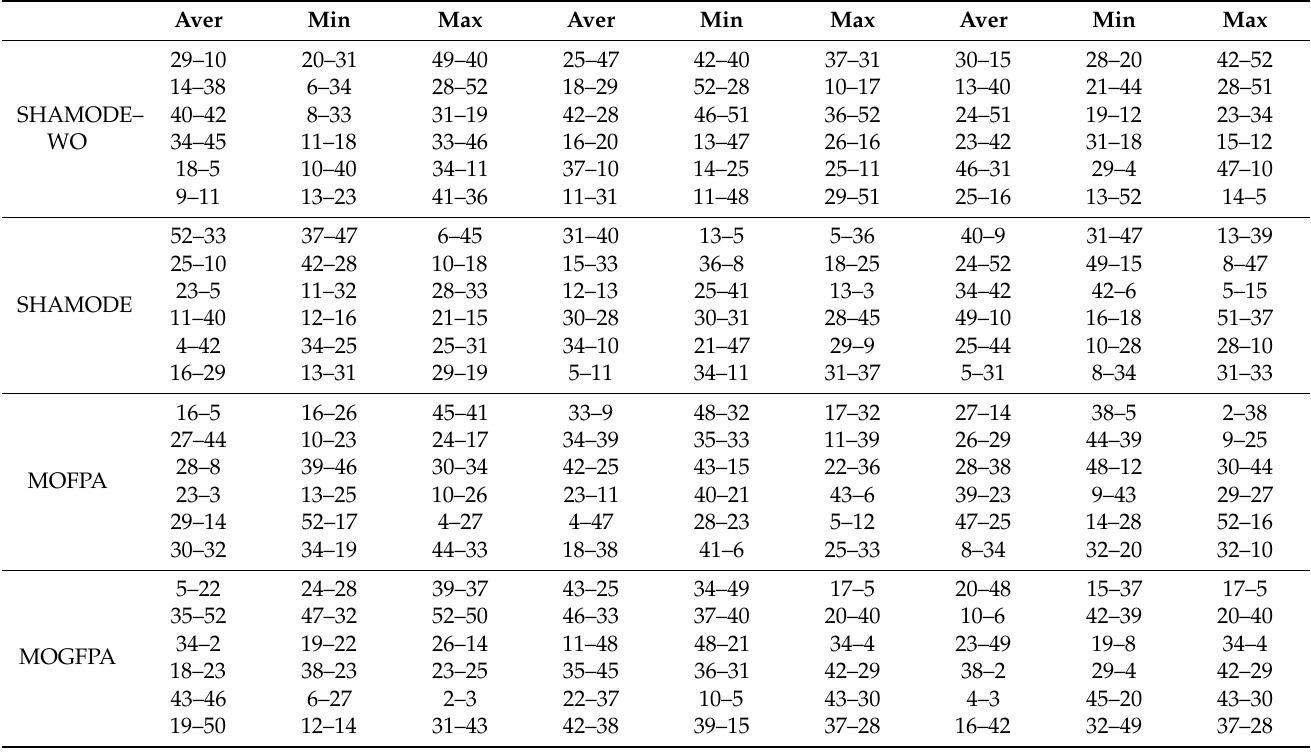
Table 7. Tie switches configuration for the Indian 52 bus